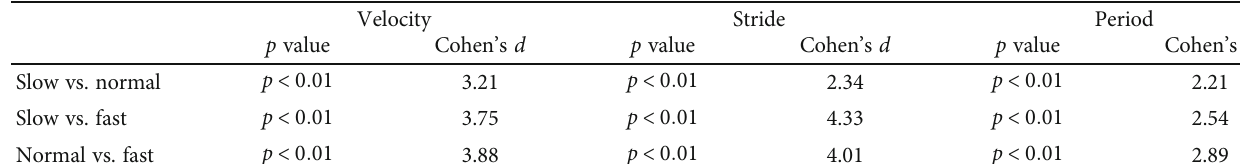
Table 2: Statistical results of post hoc test of walking speed.